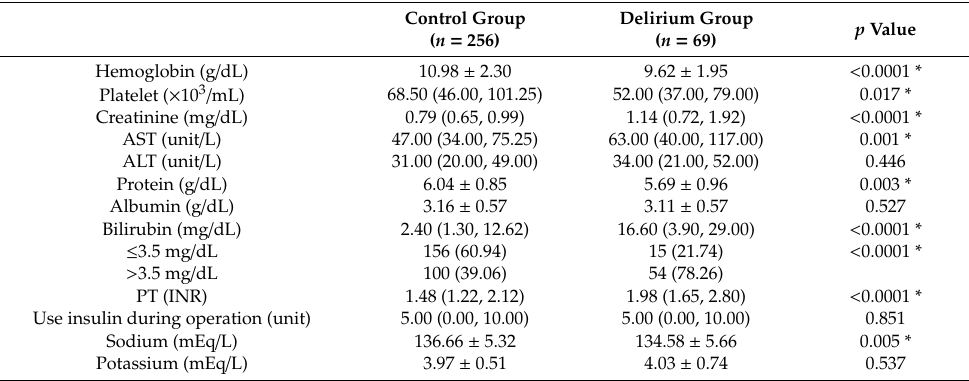
Table 2. Preoperative laboratory data in patients undergoing liver transplantation. Control Group ( n = 256)